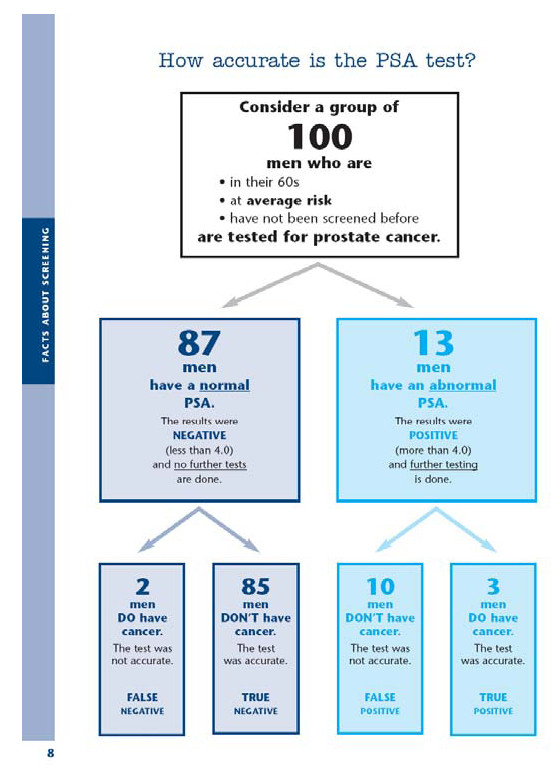
Booklet Depiction of the Accuracy of the PSA Test [83-85].